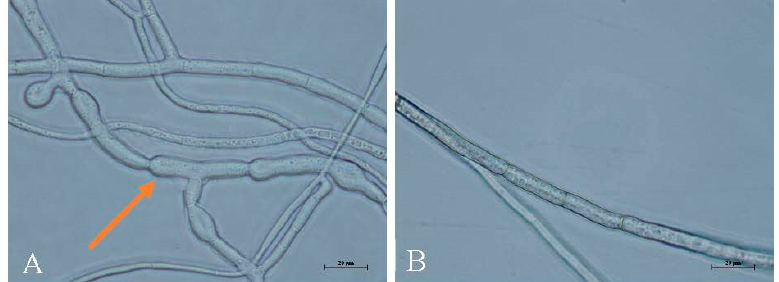
Figure 8. Morphological characterization of Monilia yunnanensis hyphae after inoculation with Trichoderma T6 fermentation (20-fold) at 7 days: ( A ) the hyphae of M. yunnanensis was enlarged and malformed after inoculation with Trichoderma T6 fermentation; ( B ) the normal hyphae of M. yunnanensis in the control group after inoculation with sterile water (Control). The arrow represents the enlarged and malformed hyphae. Table 2. Inhibitory activity levels of Trichoderma T6 fermentation products on the growth of the Monilia yunnanensis T8-1 isolate .